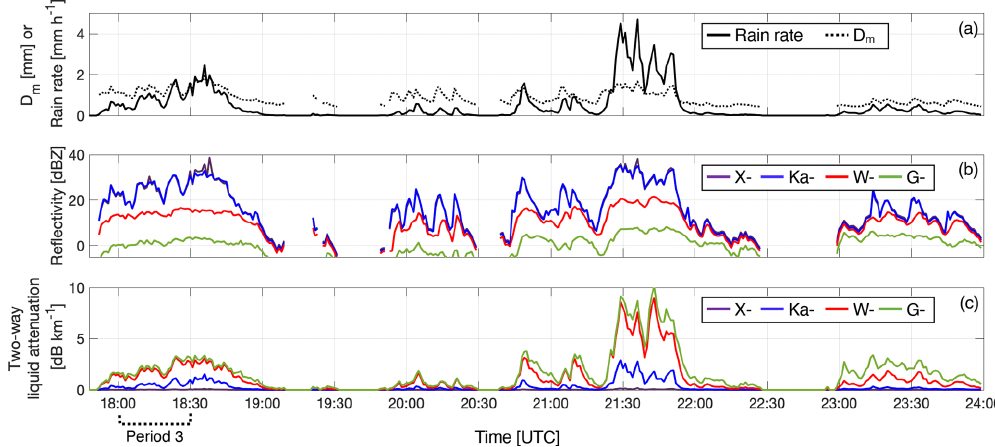
Figure 3. Based on measurements from the Parsivel 2 disdrometer collected on 25 February 2020, time series of estimated (a) particle size distribution mass-weighted mean diameter ( D m ; dotted line) and rain rate (solid line), (b) radar reflectivity, and (c) two-way liquid attenuation for X-band (purple), Ka-band (blue), W-band (red), and G-band (green)